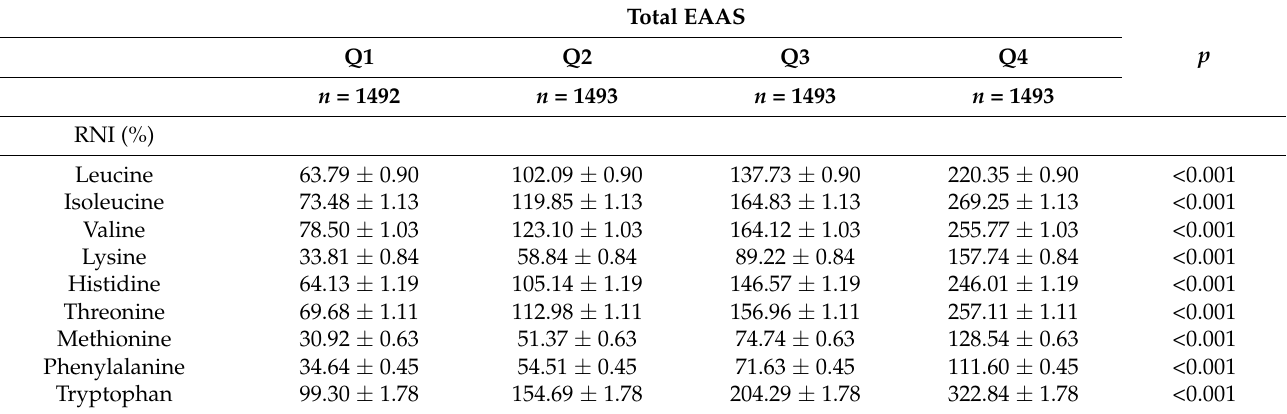
Table 3. Individual EAA intake as a percentage of the RNI for Koreans according to total